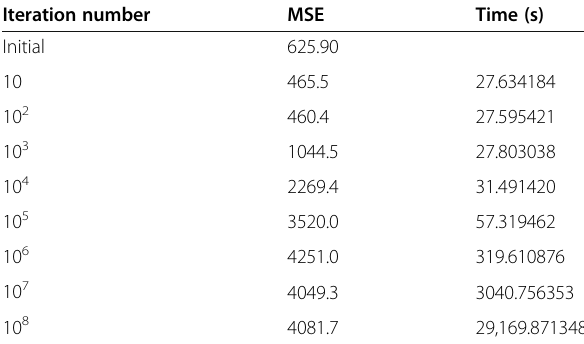
Table 2 MSEs for the Shepp-Logan phantom study with noise. Computation times are also